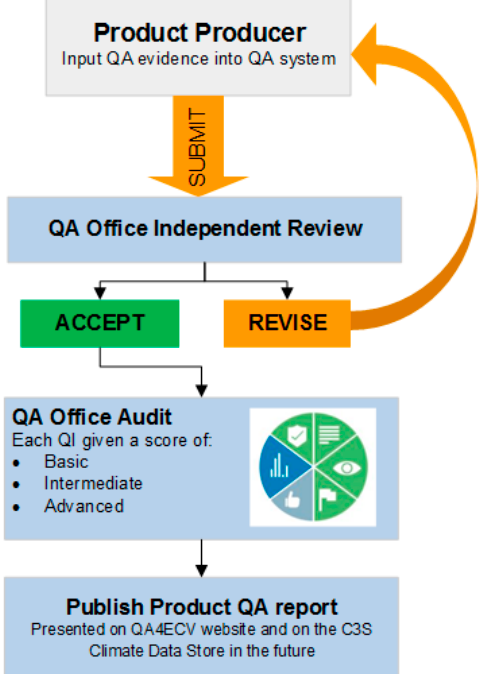
Figure 2. Overview of the QA4ECV QA system process, including the role of product producers and the QA administration. Within the QA4ECV project, the QA administration refers to domain experts for land products (National Physical Laboratory, NPL) and atmosphere products (Royal Belgian Institute for Space Aeronomy, BIRA-IASB). The revision loop provides product producers the opportunity to improve their QA evidence for each category to ensure that as much product QA information is captured as possible. Published QA reports will be made available to the public through the QA4ECV website. Future iterations of the QA reports will be made available through the Copernicus Climate Change Service (C3S) Climate Data